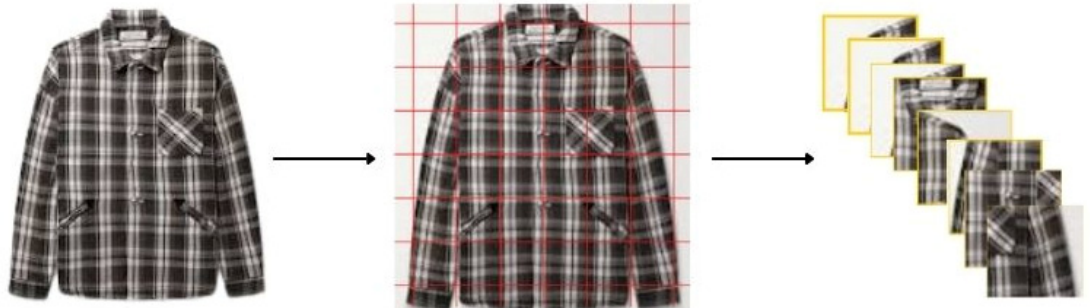
Figure 12. Feature extraction and fusion by Backbone and Neck.